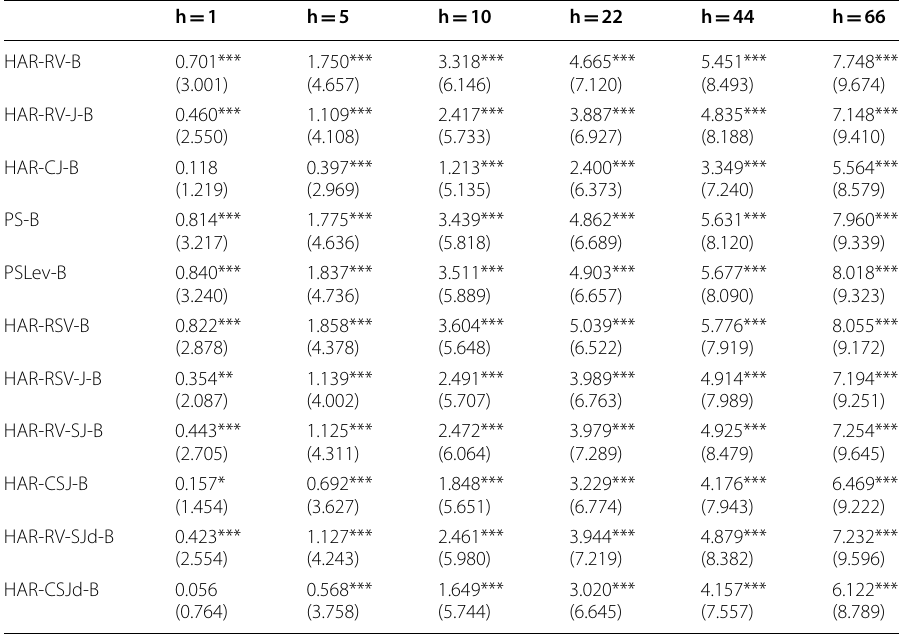
A positive difference indicates the new model with investor attention performs better than its correspondent existing model. The forecasting horizon h (unit: day) covers short-term, medium-term and long-term. T-statistic is shown in parentheses. ***, ** and * denote the statistical significance at 1%, 5% and 10%